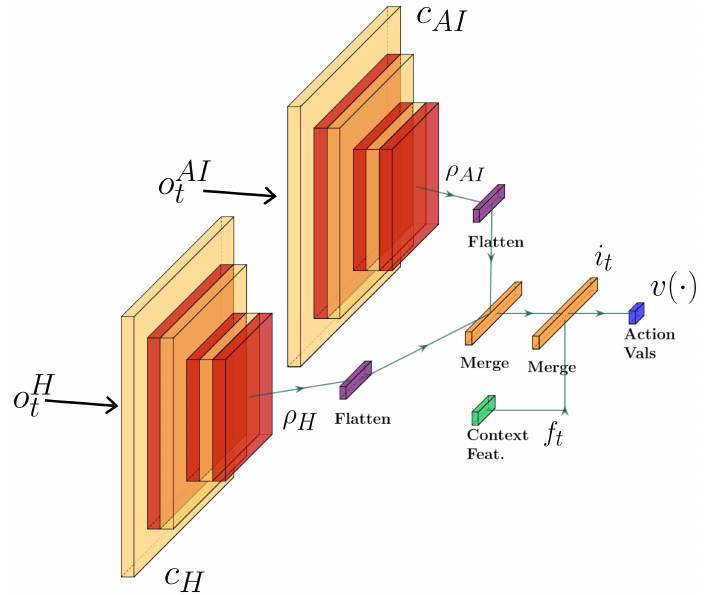
Figure 2. Manager deep reinforcement learning architecture